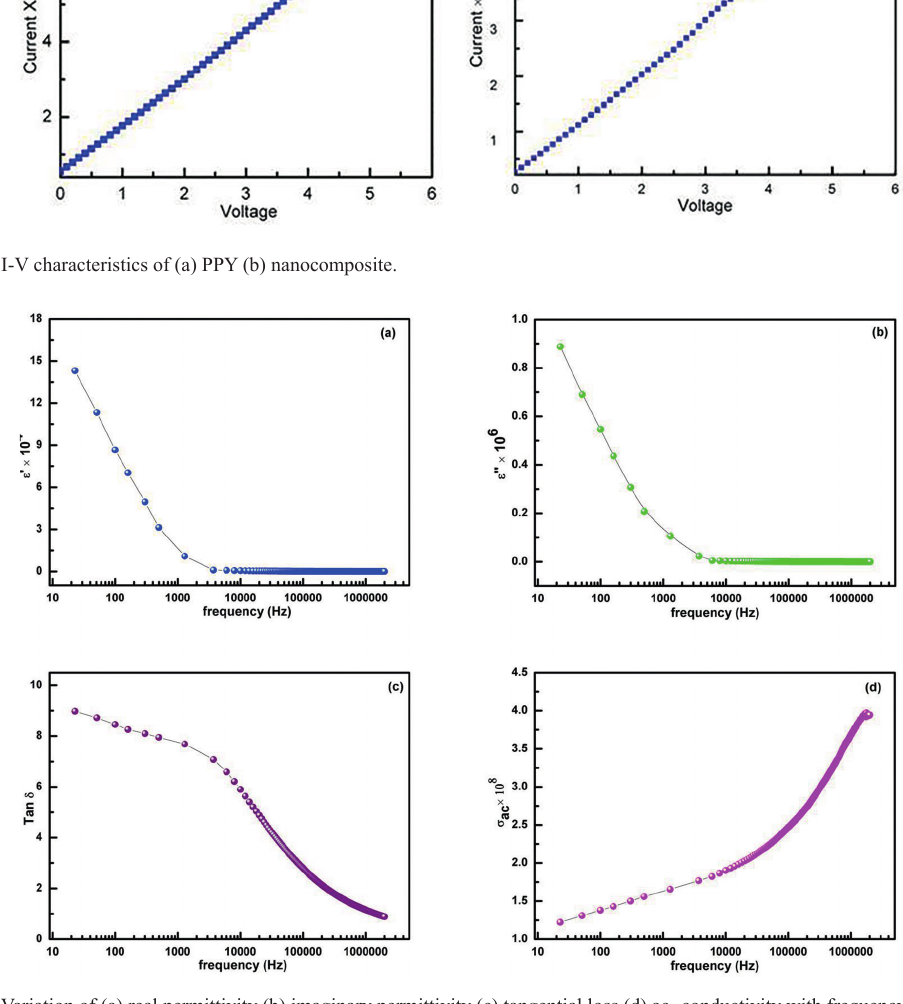
Figure 7: Variation of (a) real permittivity (b) imaginary permittivity (c) tangential loss (d) ac- conductivity with frequency.